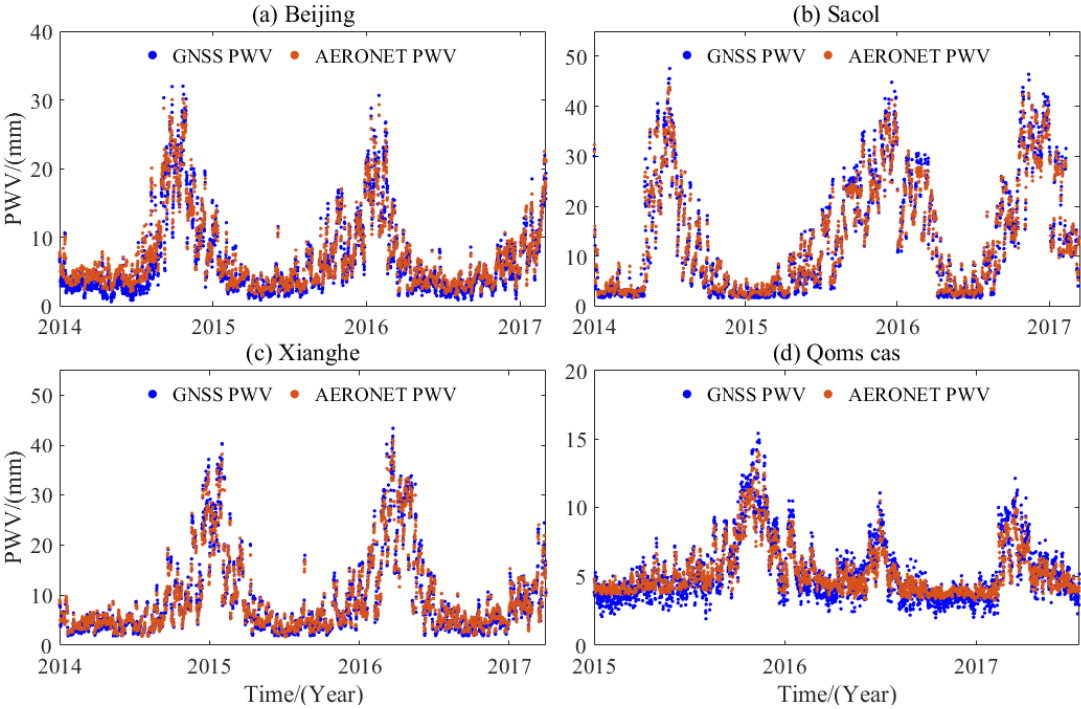
Figure 7. Time series of hourly PWV derived from AERONET and GNSS at four collocated stations during the period 2014–2017.